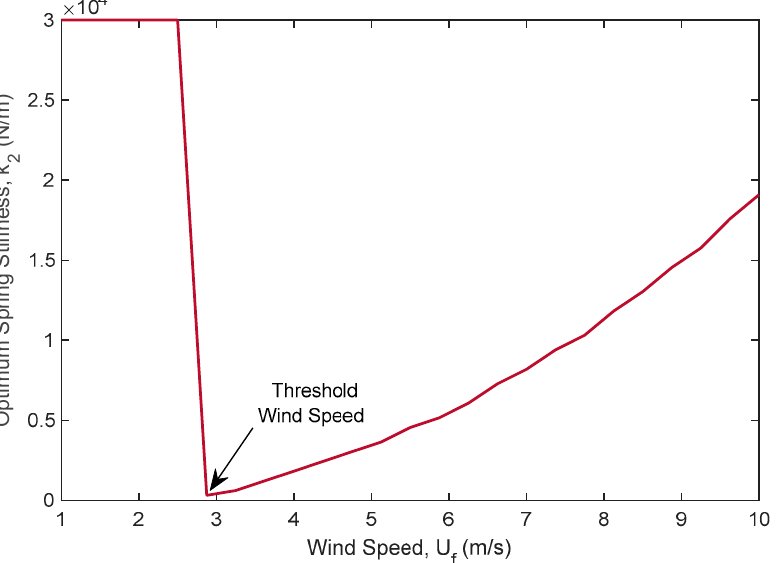
Figure 9. Optimum spring stiffness as a function of the wind speed. The tuneable turbine is feasible beyond a threshold wind speed of 2.875 m/s.